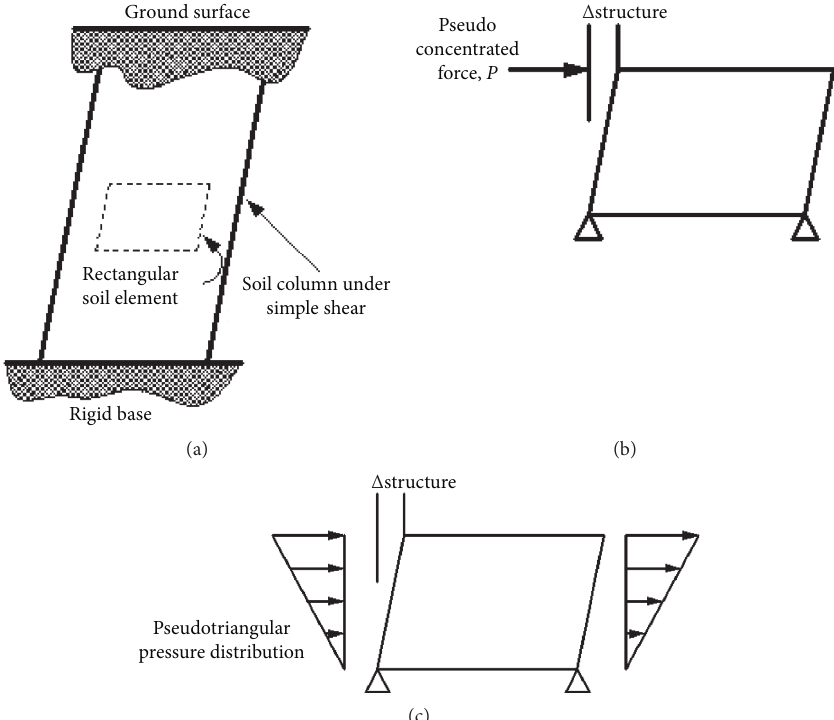
Figure 9: Simplified frame analysis mode (after Wang [13]). (a) Shear distortion of free-field soil medium. (b) Pseudoconcentrated force for deep tunnels (shear stress on the roof). (c) Pseudotriangular pressure distribution for shallow tunnels (normal stress on side wall).